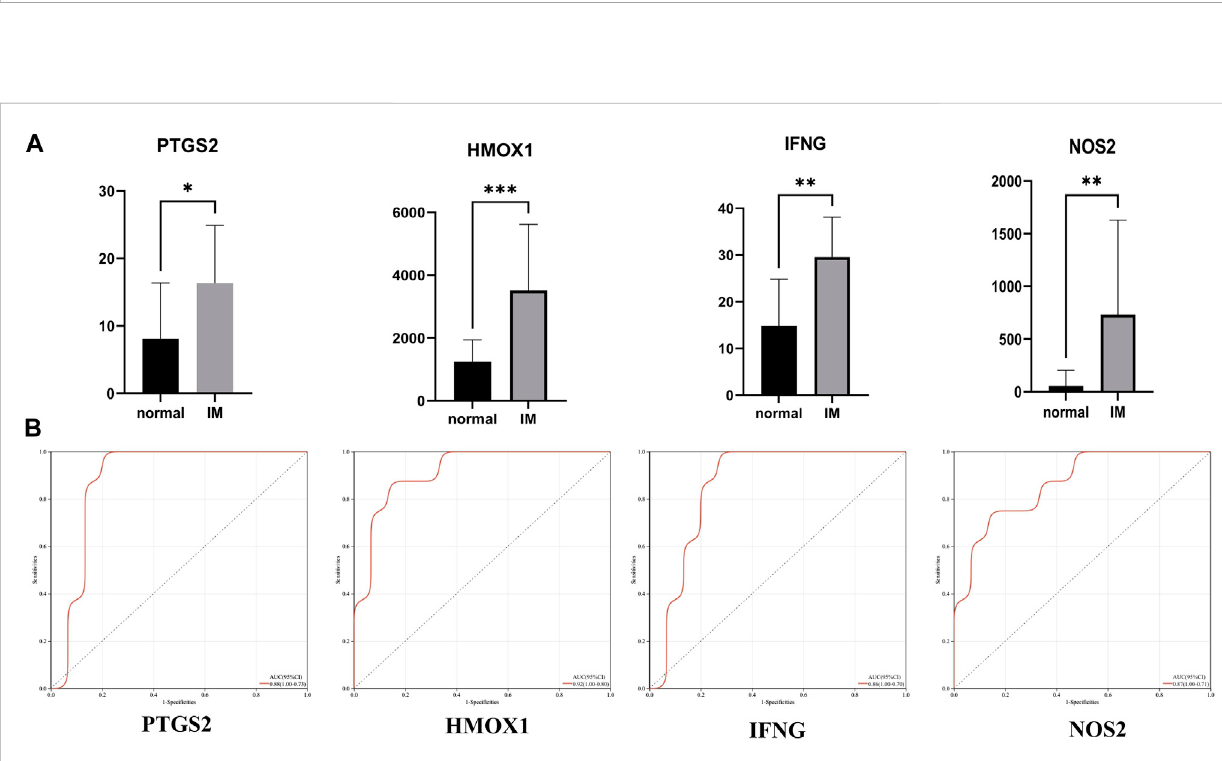
FIGURE 5 (A) Relative expression of PTGS2, HMOX1, IFNG, and NOS2 in GSE60427 dataset. (B) The receiver operating characteristic (ROC) curve of PTGS2, HMOX1, IFNG and NOS2 in GSE60427 dataset. * p < 0.05; ** p < 0.01; *** p <